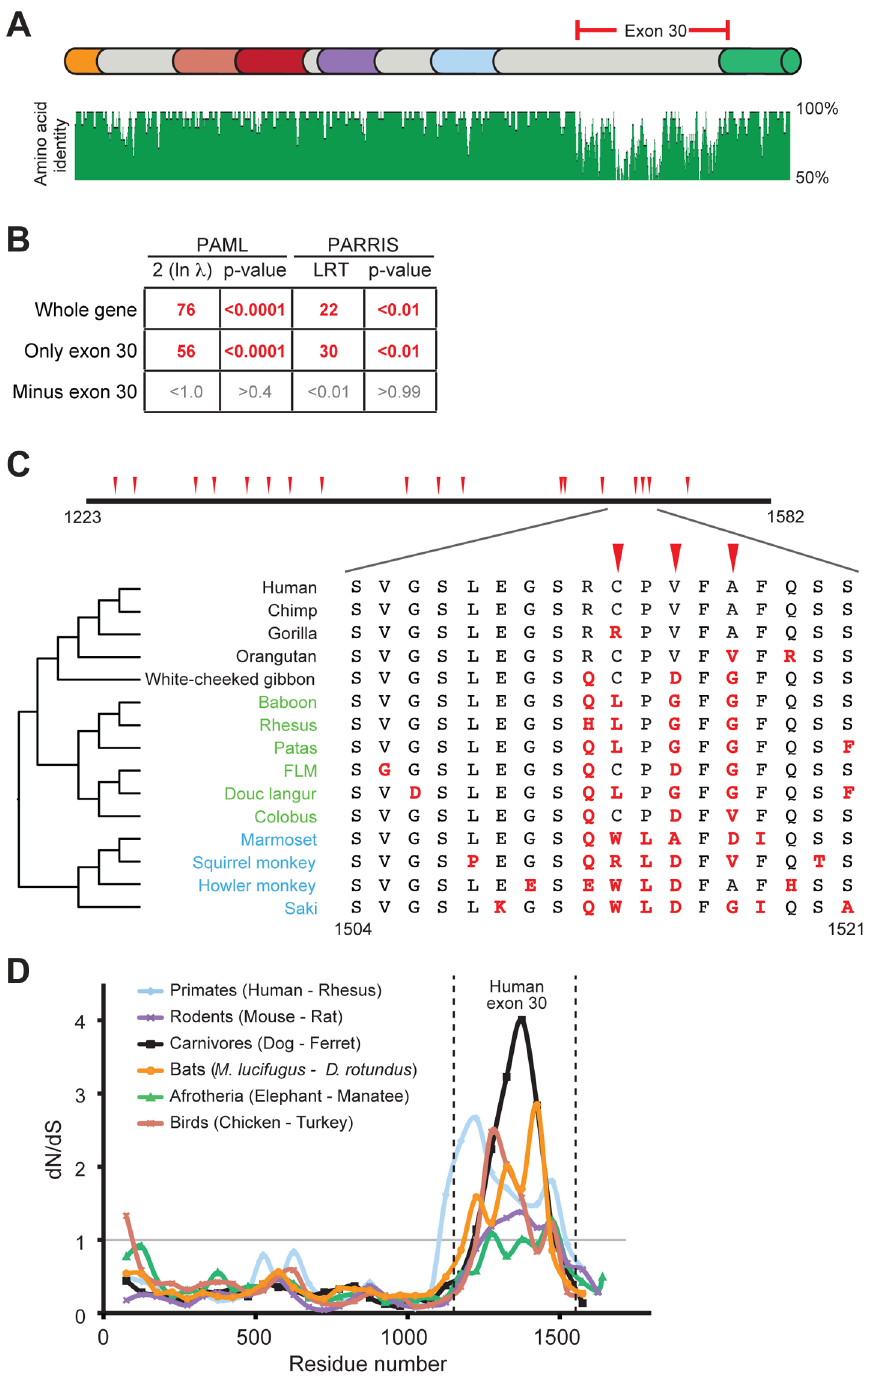
Figure 2. Positive selection in primate PARP4 is localized to exon 30. (A) The domain structure of human PARP4 protein is shown with domain colors as in Figure 1A. The region of the protein corresponding to human exon 30 is bracketed in red. Also shown below the schematic is an amino acid identity plot calculated using seven publicly available primate PARP4 sequences. (B) Results of maximum likelihood tests for positive selection from seven publically available PARP4 sequences using the entire gene, exon 30 alone or the entire gene except exon 30. Columns are as in Figure 1B. (C) An expanded view of exon 30 (residues 1223 to 1582 in human PARP4). Codons evolving under recurrent positive selection in an analysis of 15 primate species are marked with red triangles (posterior probabilities greater than 0.95) (see also Table S4). Below is a further expanded view of the alignment of residues 1504 to 1521 across all primates, with the phylogenetic tree shown to the left (Hominoids (black), Old World monkeys (green) and New World monkeys (blue)). Residues in red are changes from the human protein. (D) A sliding window dN/dS analysis of several pairs of vertebrate PARP4 genes using a window size of 150 codons and a step size of 50 codons. The grey horizontal line marks a dN/dS value of 1, indicating neutral evolution. The vertical dashed lines outline the relative position of human exon 30. dN/dS values and confidence intervals from analyses of the largest exon of PARP4 from various vertebrate pairwise comparisons are shown in Table S3.